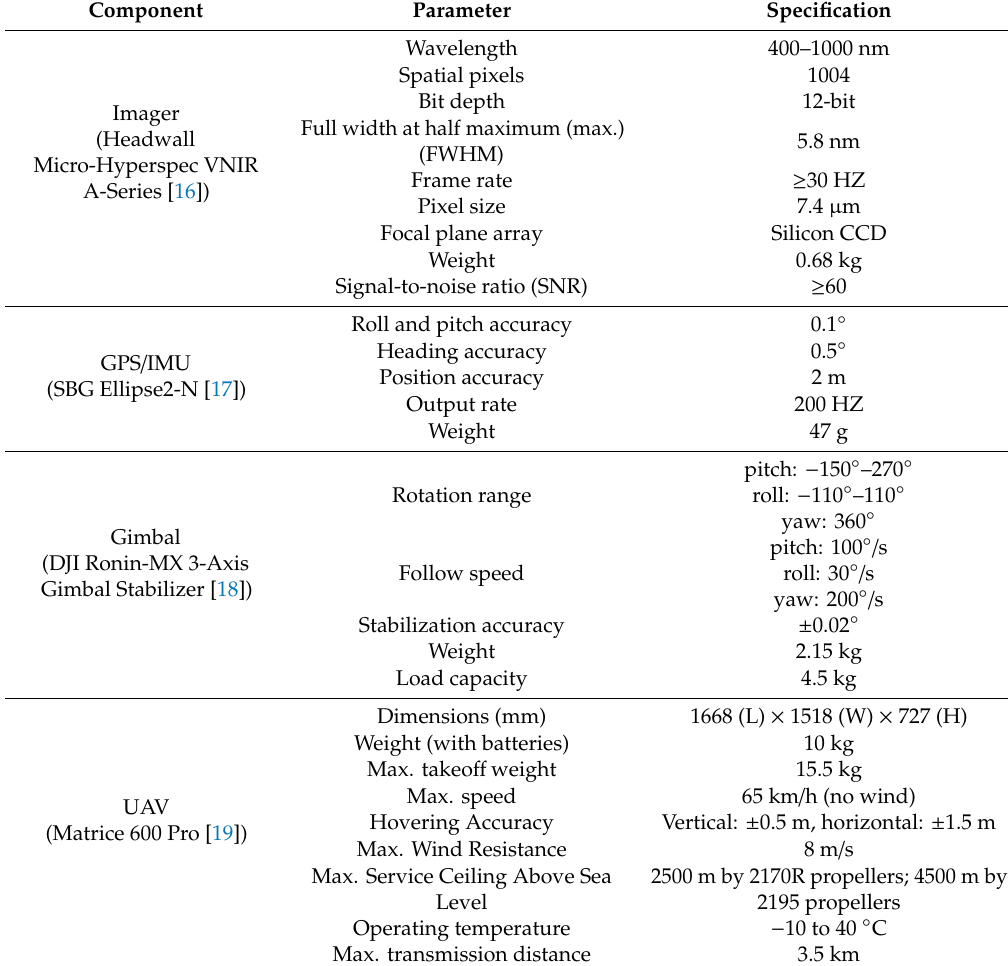
Table 1. Main specifications for some components of the hyperspectral UAV